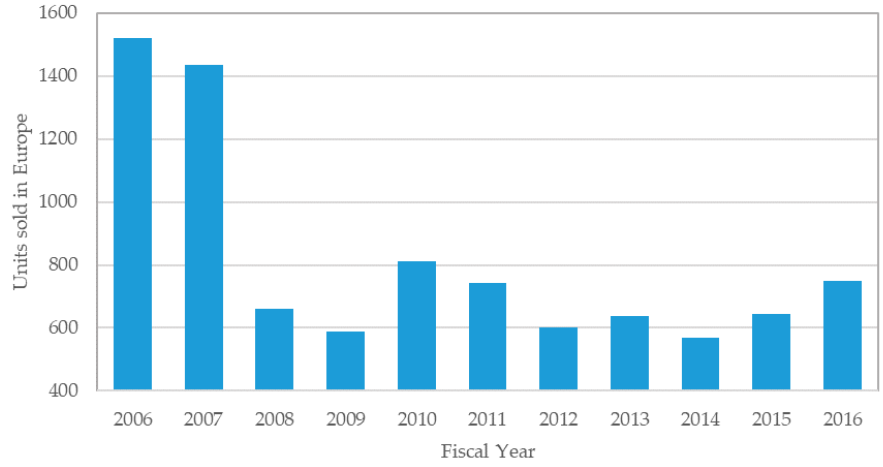
Figure 32. GEHPs installed in Europe (2006–2016).